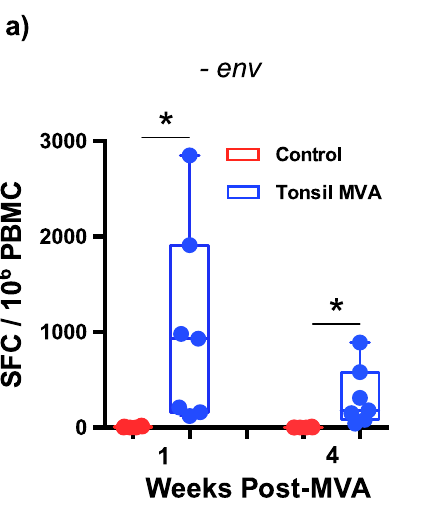
( n =7) prior to challenge with SIVmac251 as compared to control ( n =6) animals. Data arereported as spot forming counts (SFC)/10 6 cells. Box plots show minima, 25% percentile, median, 75 percentile and maxima. Statistical analysis was per- formed using one-tailed Mann – Whitney U test and a P <0.05 (*) was considered signi fi cant. * indicate P <0.05. Error bars represent standard